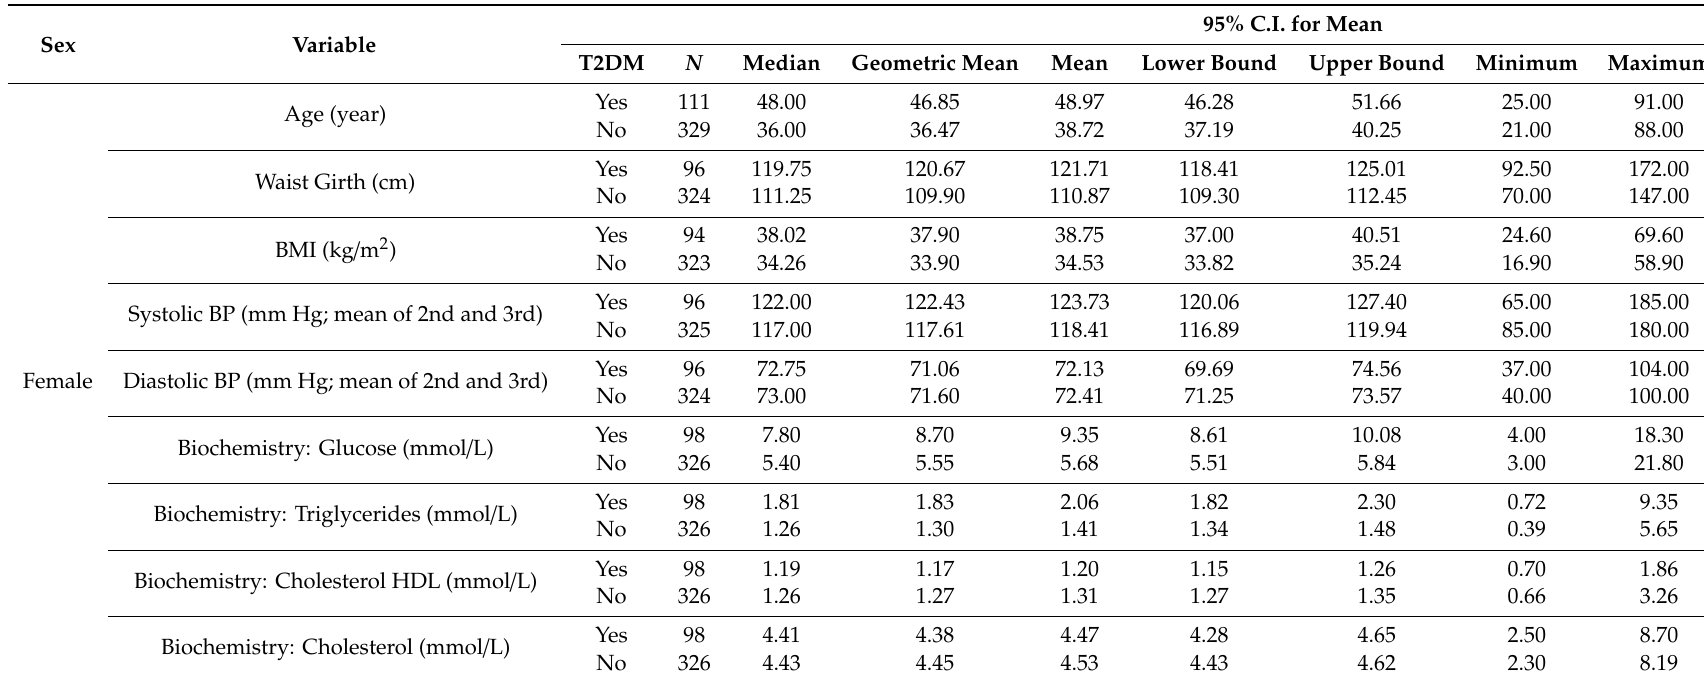
Table 1. Descriptive statistics for female ( n = 440) and male ( n = 315) participants, with and without diagnosed type 2 diabetes mellitus (T2DM).